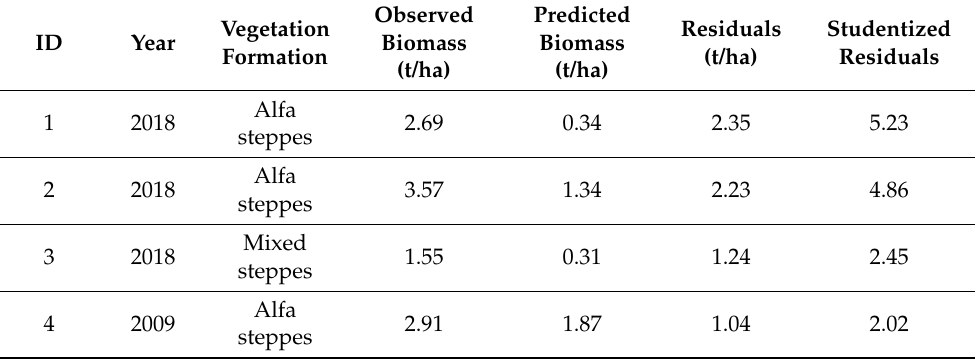
Table 5. Characteristics of the observations with the highest values of studentized residuals (out- side the [ − 2, 2] interval) for the prediction of rangeland biomass from the validation sample by Random Forest. Predicted Observed Residuals Studentized Vegetation Biomass Biomass ID Year (t/ha) Residuals Formation (t/ha) (t/ha)